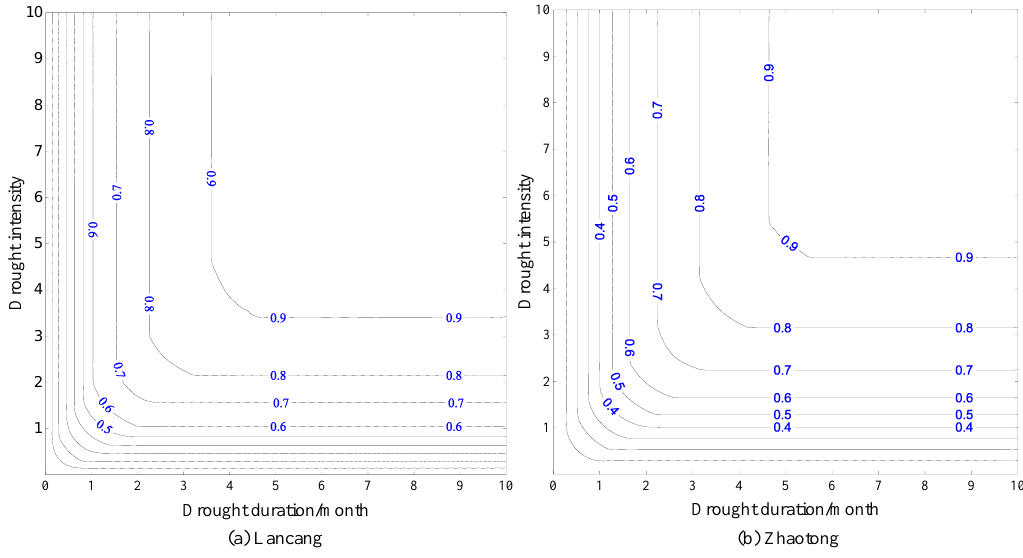
Figure 4. Joint cumulative probability contour line (a) Lancang; (b) Zhaotong.